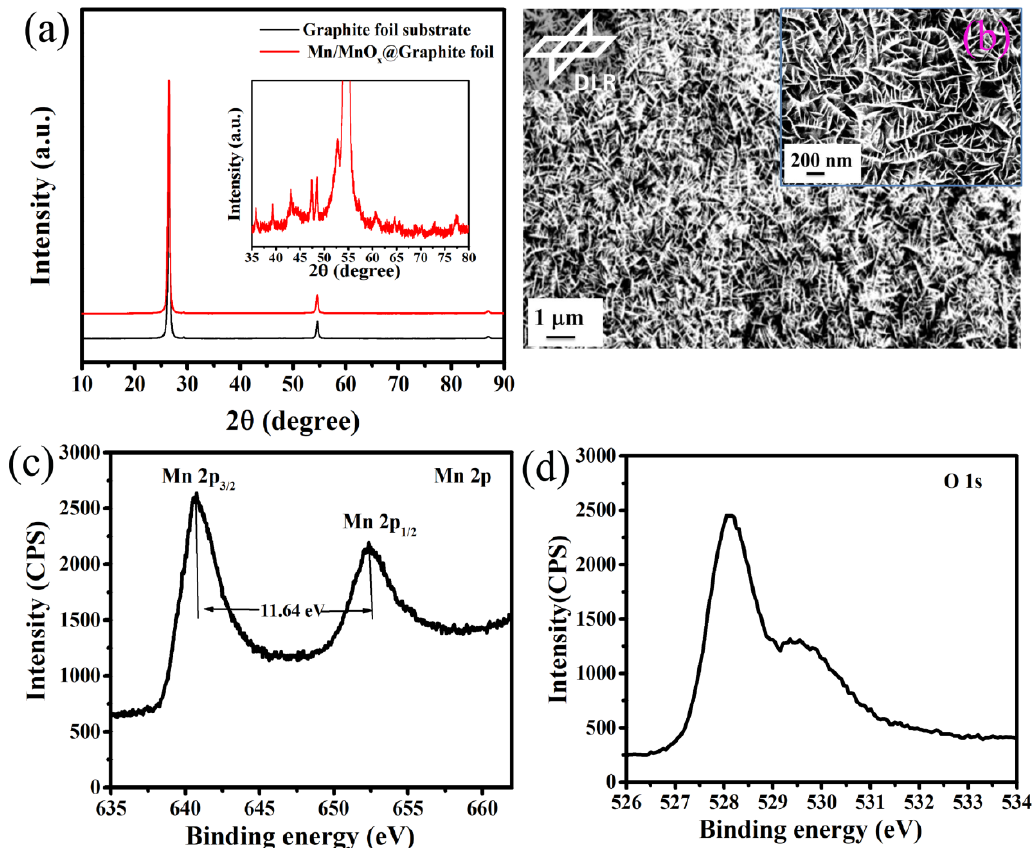
Figure 1. ( a ) XRD patterns, ( b ) FE-SEM images, ( c , d ) XPS spectra of Mn 2p and O 1s of Mn/MnO x @Graphite-foil